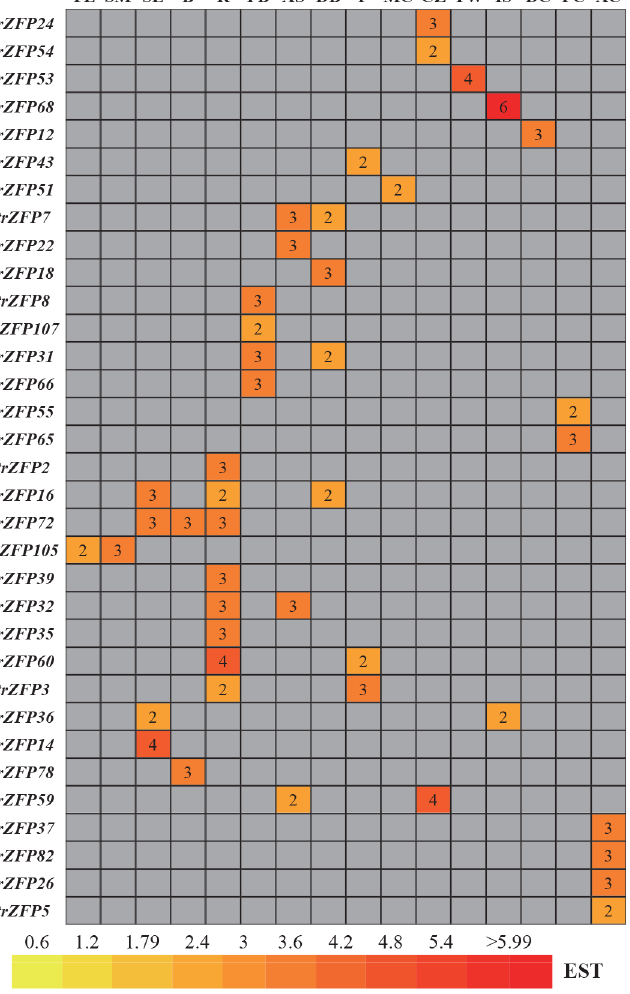
Fig 5. In silico EST analysis of Populus C2HC2-ZF genes. EST frequency for each gene was calculated by evaluating its EST representation among 16 cDNA libraries accessible using the exNorthern tool at the PopGenIE v2 database. The number in the box represents the frequencies of EST counts in different libraries. YL: young leaves, SM: shoot meristem, SL: senescing leaves, B: bark, R: roots, FB: flower buds, AS: apical shoot, DB: dormant buds, P: petioles, MC: male catkins, CZ: cambial zone, TW: tension wood, IS: imbibed seeds, DC: dormant cambium, FC: female catkins, AC: active cambium.